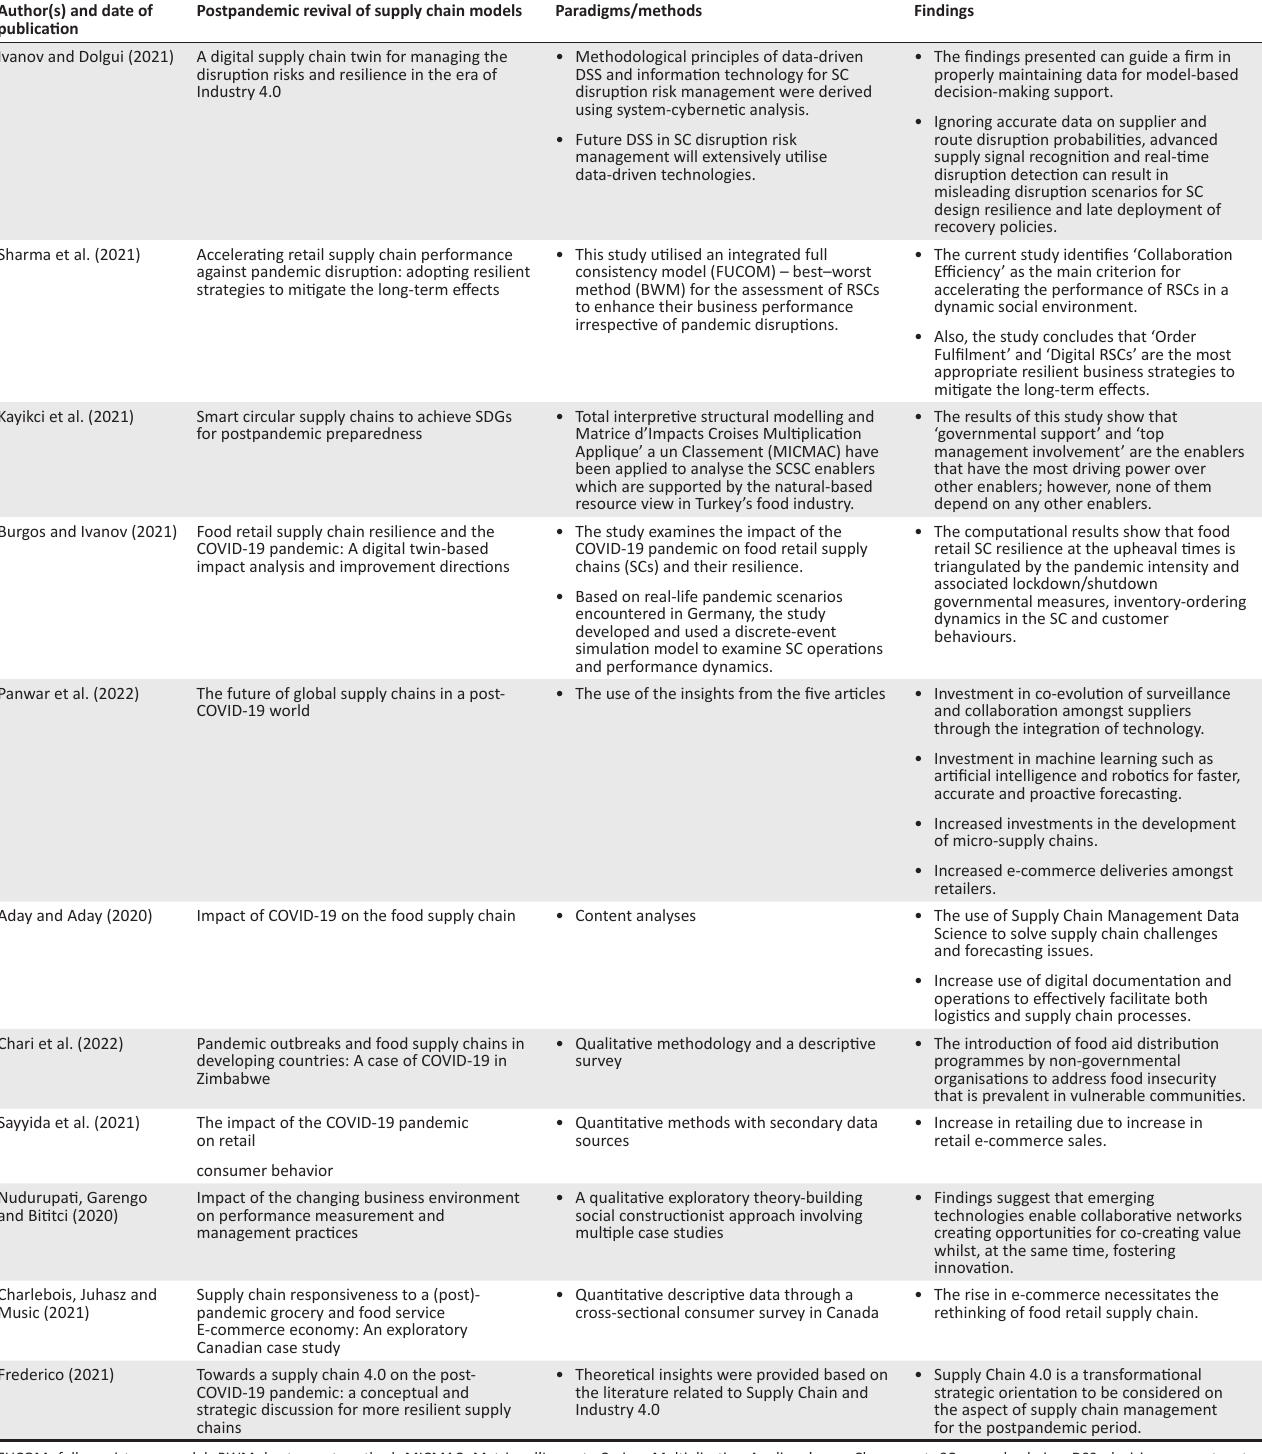
TABLE 2: Summary of postpandemic